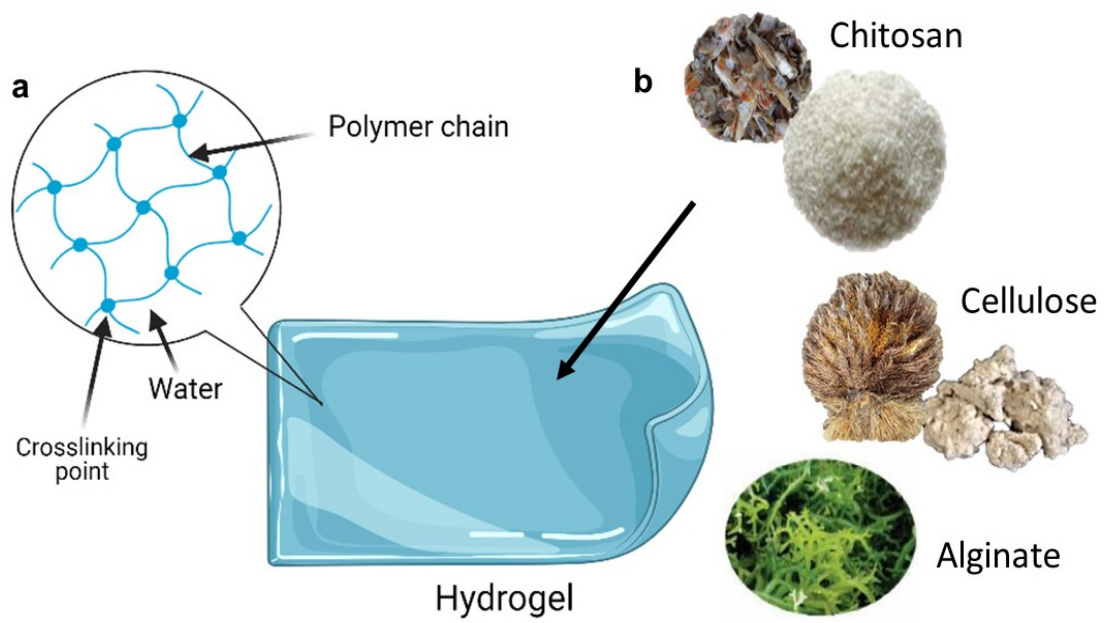
Figure 2. Schematic diagram of hydrogels: ( a ) structural composition of hydrogels; ( b ) examples of natural polymers networks (clockwise from top right) chitosan from shrimp waste, cellulose from oil palm biomass, and alginate from brown algae (created and modified with biorender.com (accessed on 2 October 2021) and adapted from [43–46]).